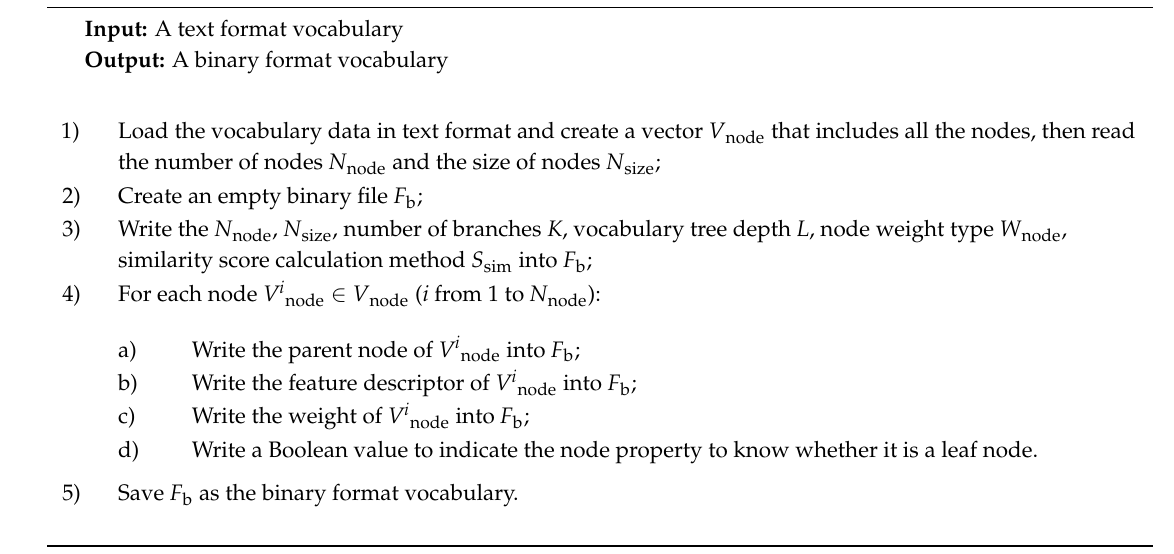
Algorithm 1: Binary-Based Vocabulary Storage Method